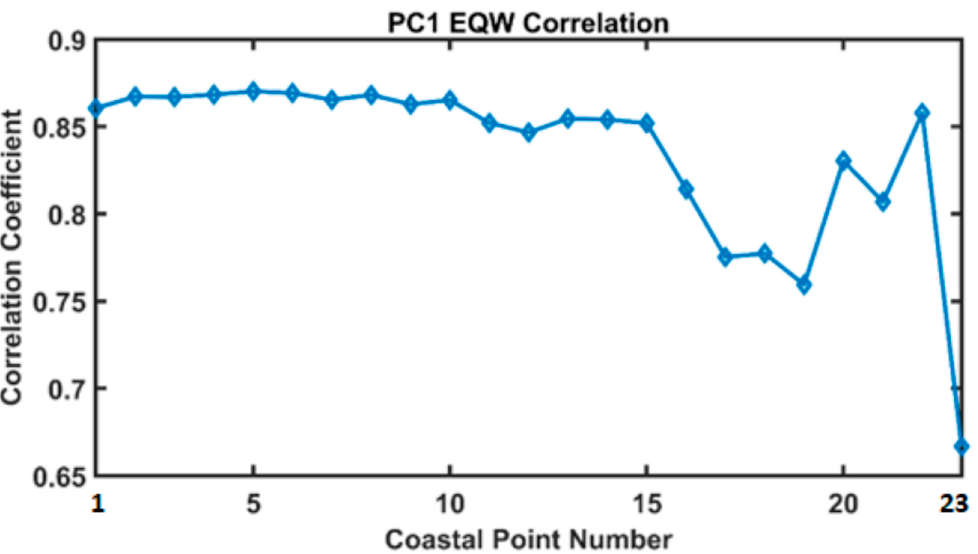
Figure 11. Correlation between the SSHA reconstructed with the first mode and equatorial zonal wind forcing.